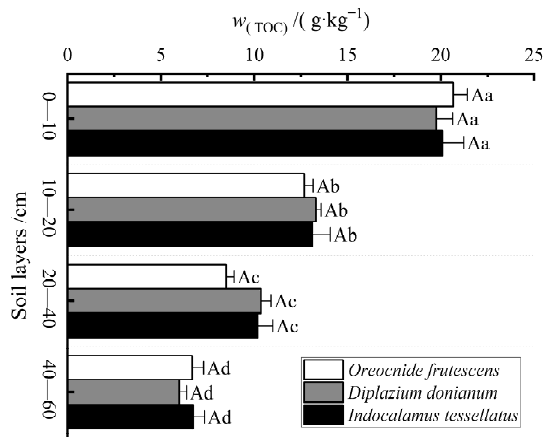
Figure 2. Soil total organic carbon mass fraction. TOC (Total organic carbon). Different uppercase letters indicate significant differences between understory vegetation types, and different lowercase letters indicate significant differences between soil layers. ( p < 0.05).